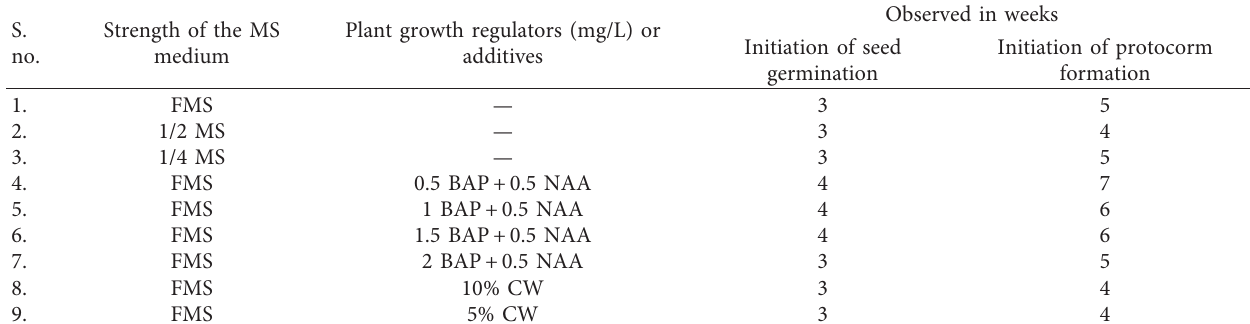
Table 2: In vitro seed germination of Dendrobium chryseum .